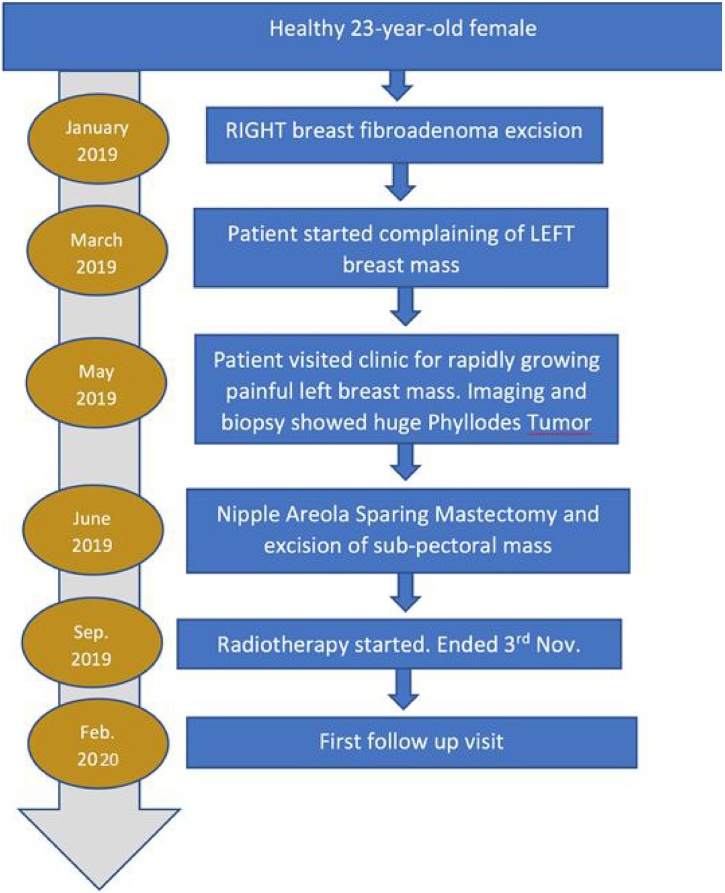
The time for diagnosis and treatment.